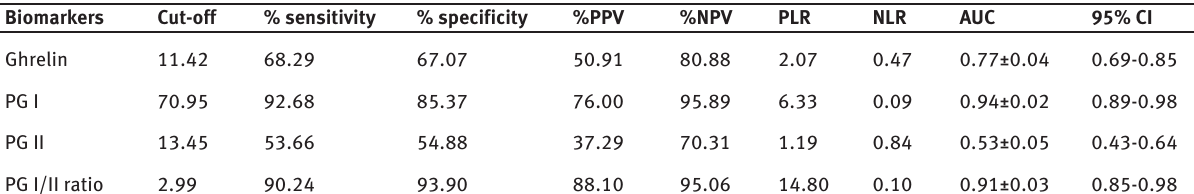
Table 4: ROC curve analysis parameters. Biomarkers